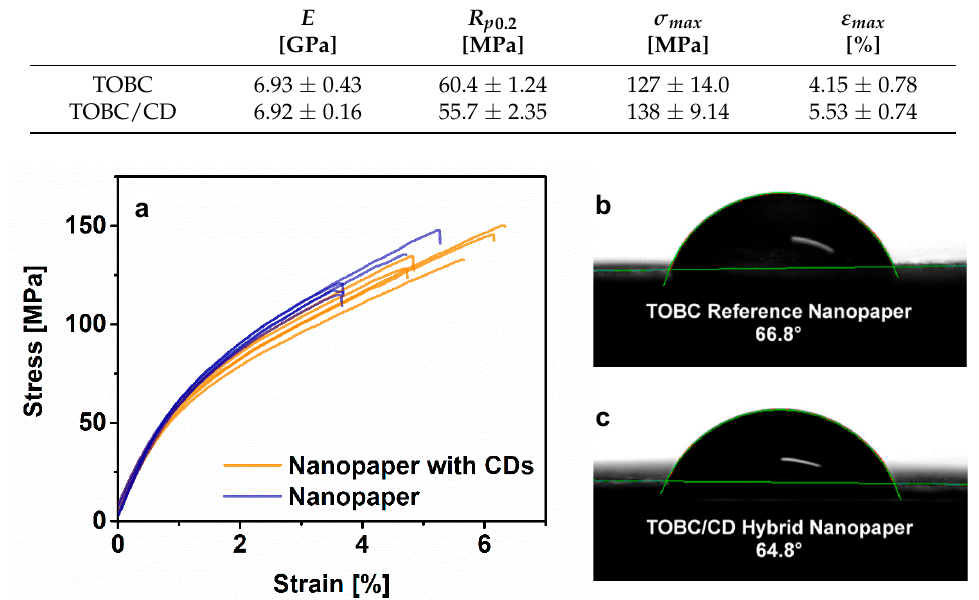
Table 1. Mechanical properties of TOBC nanopaper (3 mm wide, clamping length 20 mm) as obtained by tensile testing.